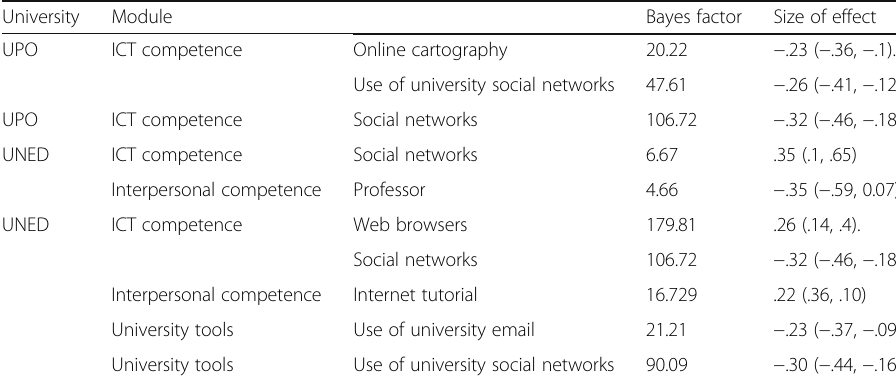
Table 4 Competences compared between the two universities in ICT use in the search and treatment of information